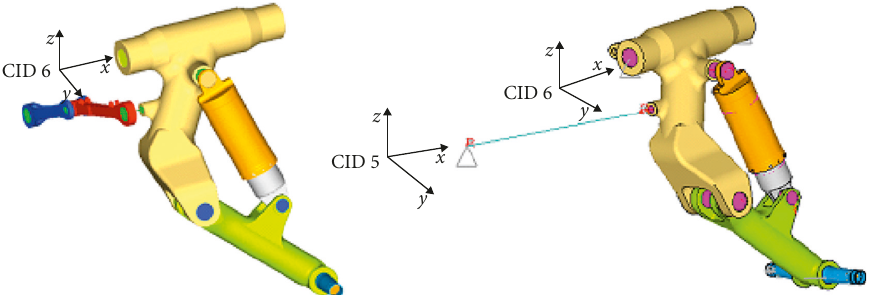
Figure 8: 3D full-FE model: second strategy.